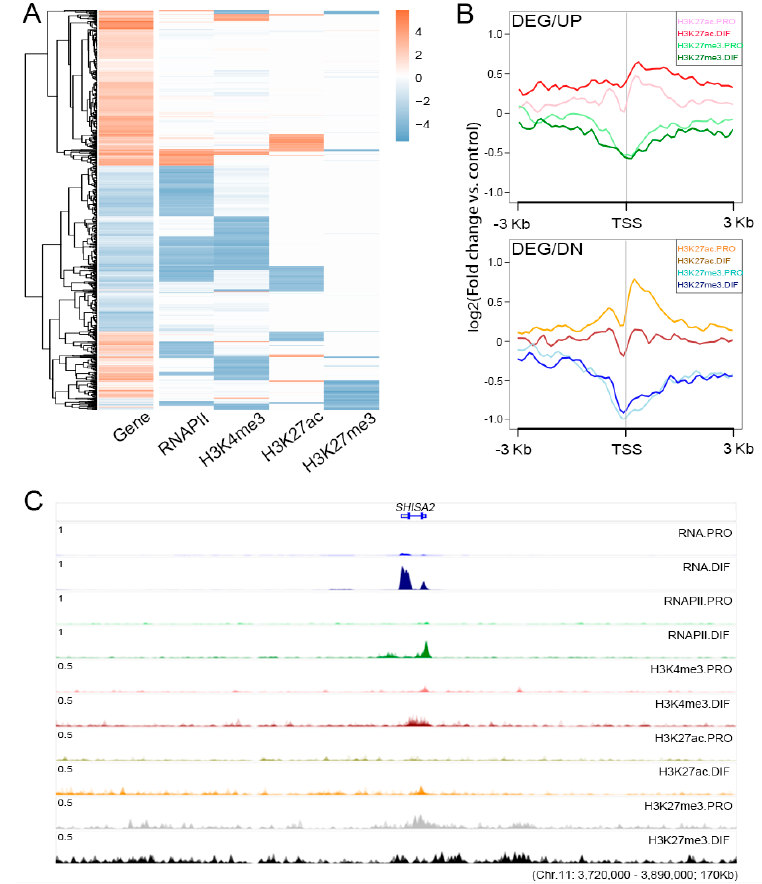
Figure 4. The relationships between epigenetic modifications and transcriptomic profiles during cell differentiation. ( A ) Heatmap illustrating the relationships between the changes of histone modifications and gene expression for the 917 DEGs during cell differentiation. ( B ) Expression profiles of H3K27ac and H3K27me3 were plotted at ± 3 kb of TSS region of DEGs to show the presumable binding sites between PRO and DIF cells. Up (DEG/UP, upper panel) and down (DEG/DN, bottom panel) regulated DEGs were described separately. The y-axis was the average log2 fold change compared with control. ( C ) The integrative genomics viewer (IGV) browser was used to show ChIP-Seq and RNA Sequencing (RNA-Seq) enrichment for the up-regulated DEG, SHISA2 , which showed that the gene was activated by the increase in RNAPII and H3K27ac combined with the depletion of H3K27me3 modification during cell differentiation.